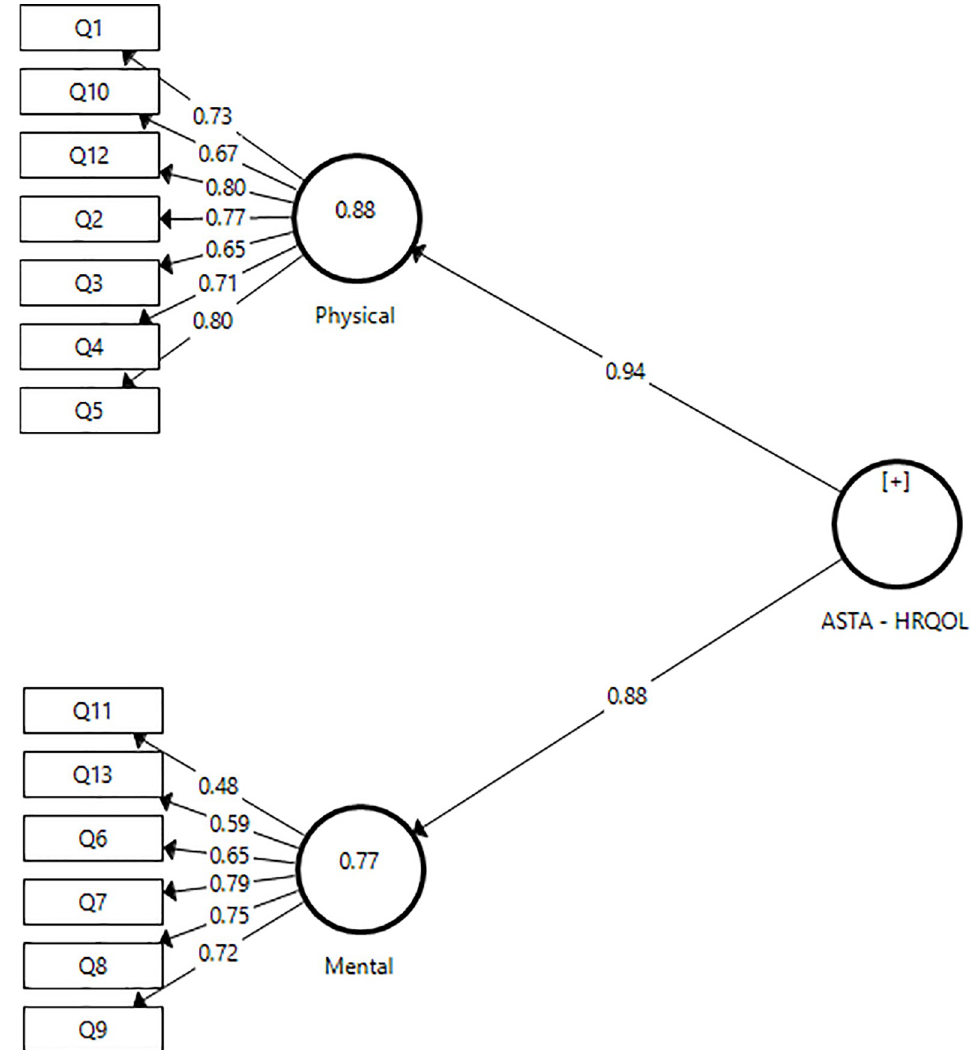
Fig 1. Structural model of the ASTS-Br-HRQOL. Source: SmartPLS